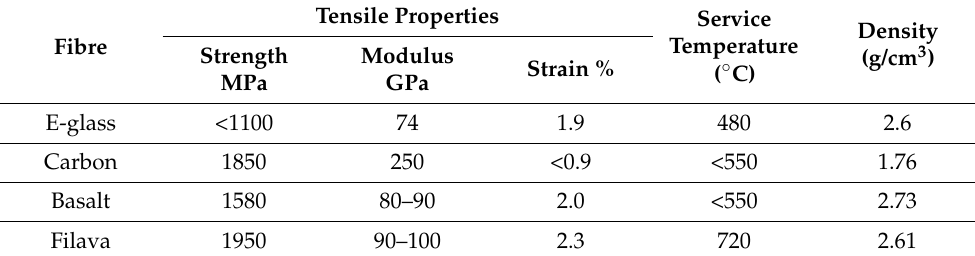
Table 1. The tensile properties of E- glass, carbon, ordinary basalt and Filava fibres as per ISO 3341 [8].